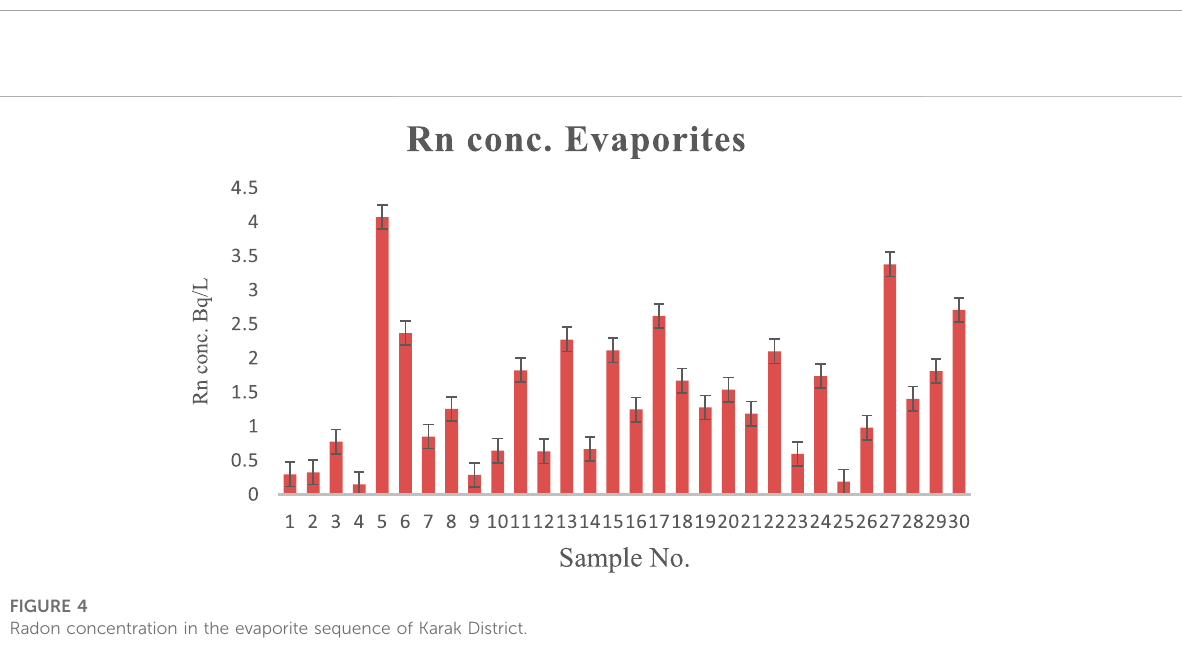
FIGURE 4 Radon concentration in the evaporite sequence of Karak